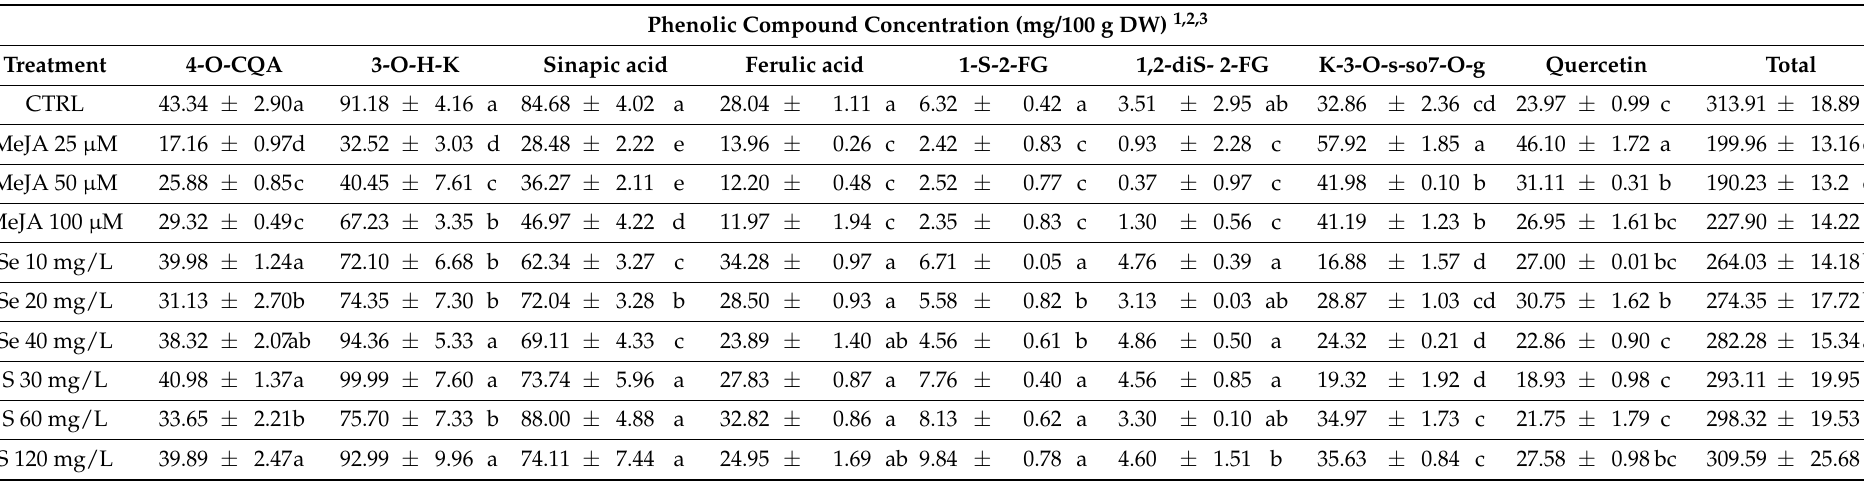
1 Concentrations are reported as each individual standard. Compounds were quantified at 320 nm: sinapic acid and ferulic acid, 4-O-caffeoylquinic acid (4-O-CQA), 1-sinapoyl-2 (cid:48) - ferulolylgentiobiose (1-S-2-FG) and 1,2-disinapoyl-2-ferulolylgentiobiose (1,2-diS-2-FG); 360 nm: kaempferol 3- O -sophoroside-7O-glucoside (K-3-O-s-so7-O-g), 3-O-hexoside kaempferol (3-O-H-K) and quercetin. 2 Values represent the mean of three replicates ± standard error of the mean. 3 Different letters in the same column indicate statistical differences in the concentration of each compound between treatments using the least significant difference (LSD) test ( p <